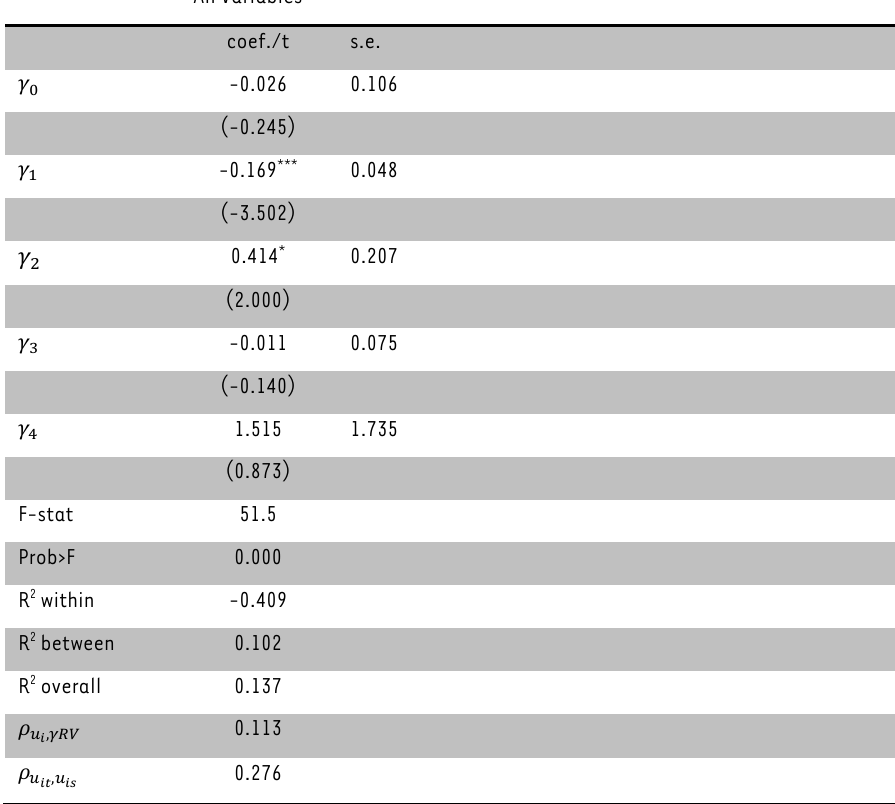
TABLE 5: Panel Data Regression Results: All risk variables All Variables coef./t